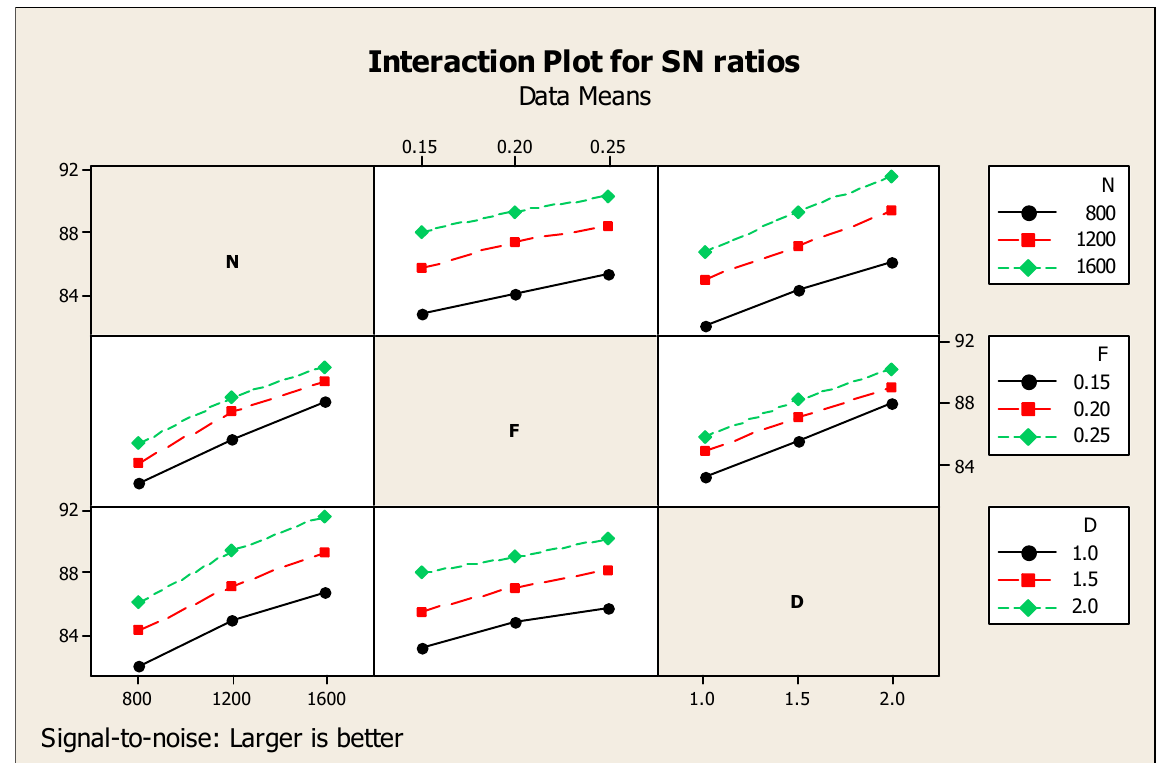
Figure 6. MRR interaction diagram.